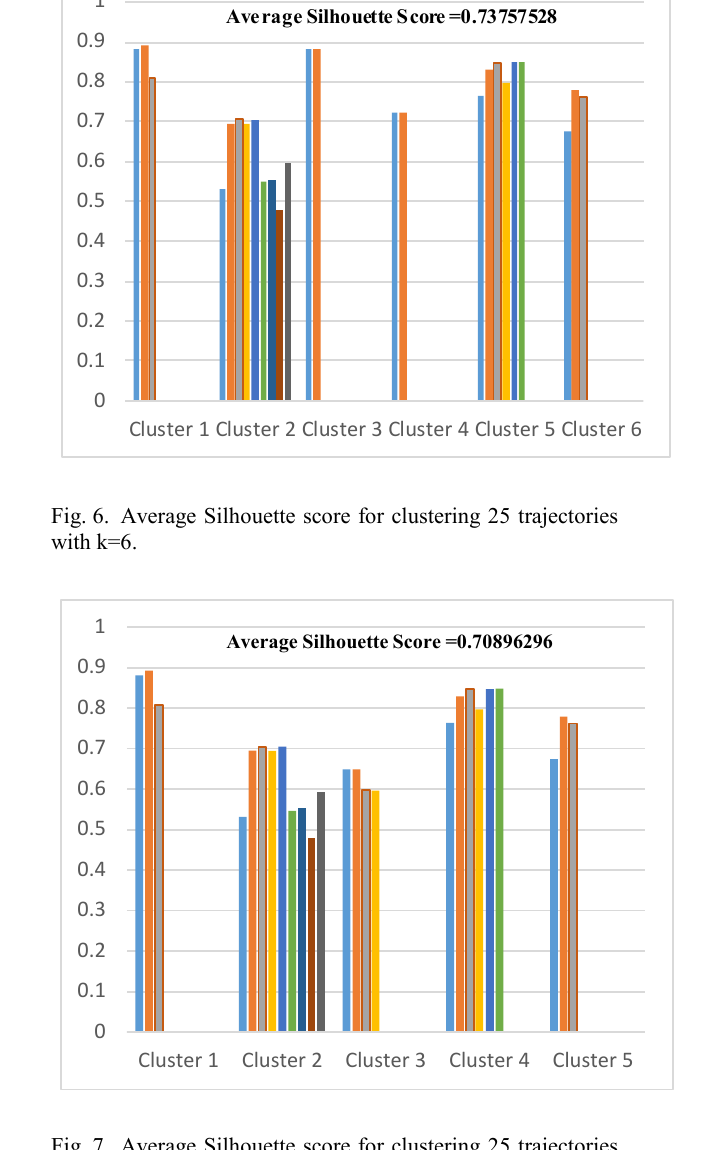
Fig. 7. Average Silhouette score for clustering 25 trajectories with